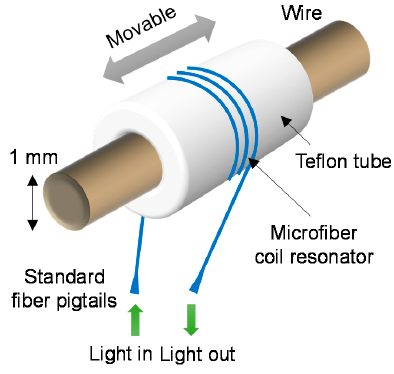
Figure 13. Schematic diagram of the microfiber coil resonator-based thermometer sliding along an electrical wire to measure the local temperature.